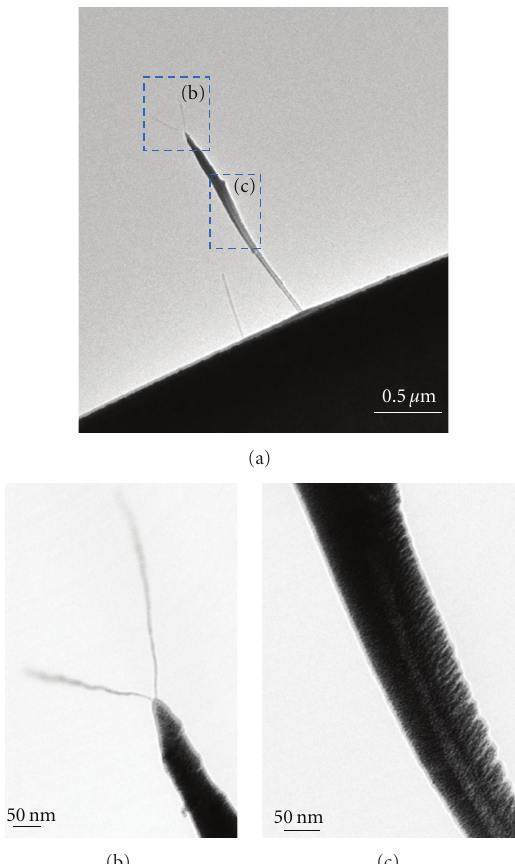
Figure 5: TEM images of the hybrid nanowire: (a) low magnification image, (b) joint section of the hybrid nanowire, and (c) body of the platinum nanowire.